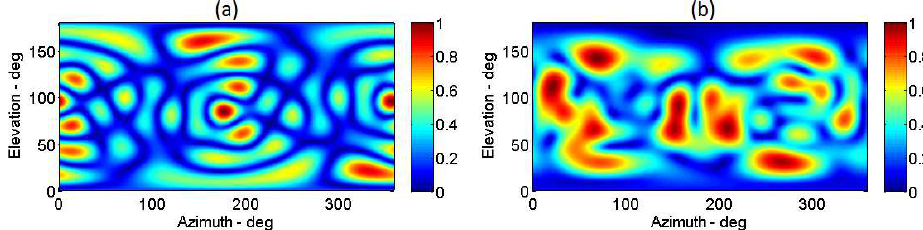
Figure 12. Normalized amplitude PWE at 63 Hz ( a ) and 250 Hz ( b ), non-regularized, q q (250) = 7 × 10 − 4 . total